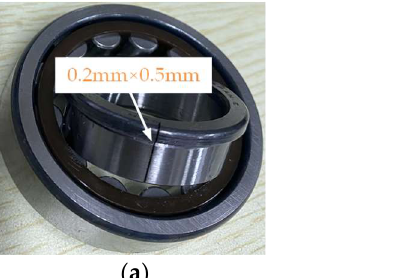
Figure 6. Defective bearings: ( a ) localized defects on inner ring; ( b ) localized defects on outer ring. The load and input speed for the test bearing were set as 800 N and 2400 rpm, with fit clearance as 0.05 mm. In the compared model, the housing stiffness and damping coefficient were set as 1.5 × 10 7 N/m and 1800 Ns/m [18], the contact stiffness and friction coefficient between outer ring and housing were 1.5 × 10 7 N/m and 0.3 and the viscous damping was 1800 Ns/m. For the bearing components, the density was 7.75 × 10 3 kg/m 3 , the elasticity modulus was 2.0 × 10 7 N/m 2 and the Poisson ratio was 0.25. In the experiment, the vertical acceleration was obtained using the acceleration sensor, and the sampling frequency was 30 kHz. Compared with the spectrum signal, defect frequencies in the envelope spectrum were more obvious. Next, the time domain signals were processed by the envelope spectrum for frequency components in the bearing. On the basis of the equations in Appendix A, the shaft frequency f r was 40 Hz, cage frequency f c was 16.1 Hz, roller passing outer raceway frequency f o was 209.4 Hz and the roller passing inner raceway frequency f i was 310.6 Hz. The comparison results for the inner ring defect can be seen in Figure 7. where there are periodic shock zones in the acceleration signals of the model and experiment, the time interval between shock zones is the same as 1/ f r , and the time lag between the impacts in the shock zone is in line with 1/ f i ; and the rotor frequency f r , inner ring defect frequency f i and the harmonic frequencies 2 f r , f i − f r , f i + f r , 2 f i − f r , 2 f i , 2 f i + f r can be found in the envelope spectrums.